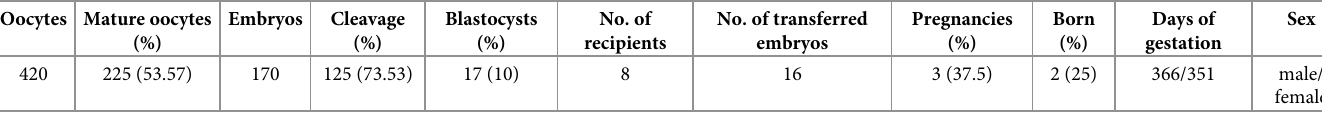
Table 1. In vitro and in vivo development of embryos obtained after a SCNT procedure using MSCs of a male donor. Oocytes Mature oocytes